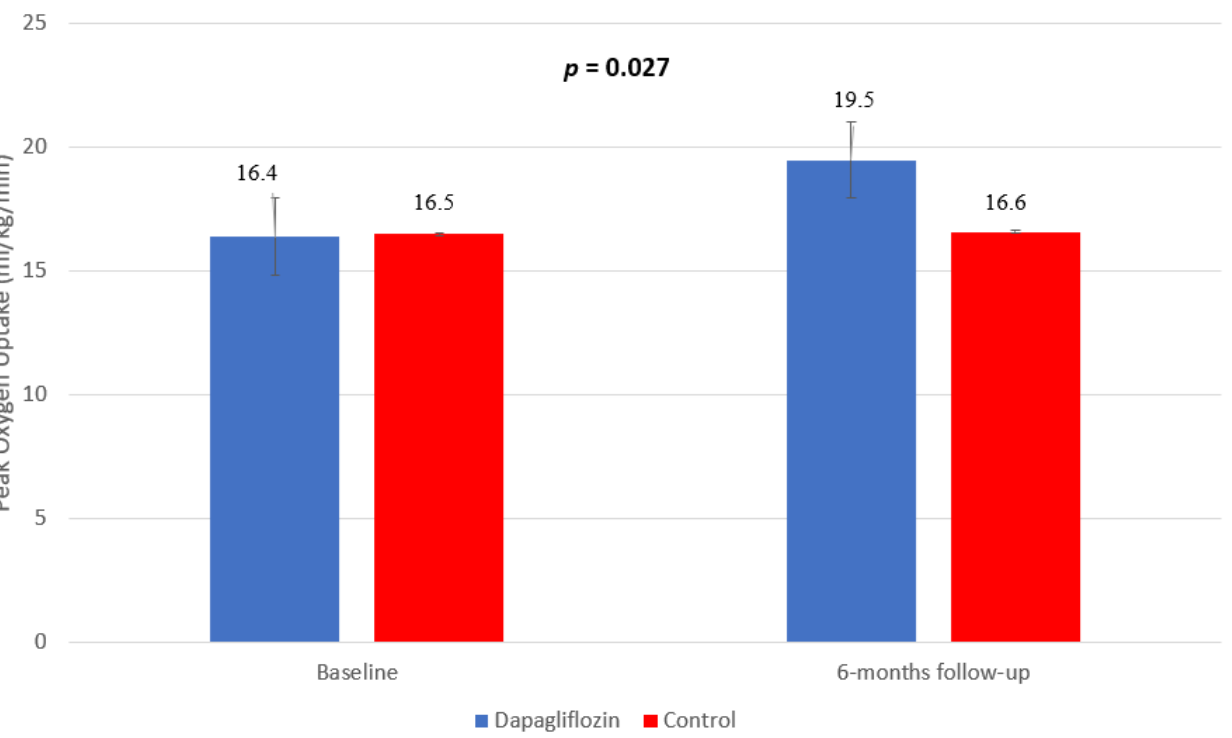
Figure 1. Study design and population selection.